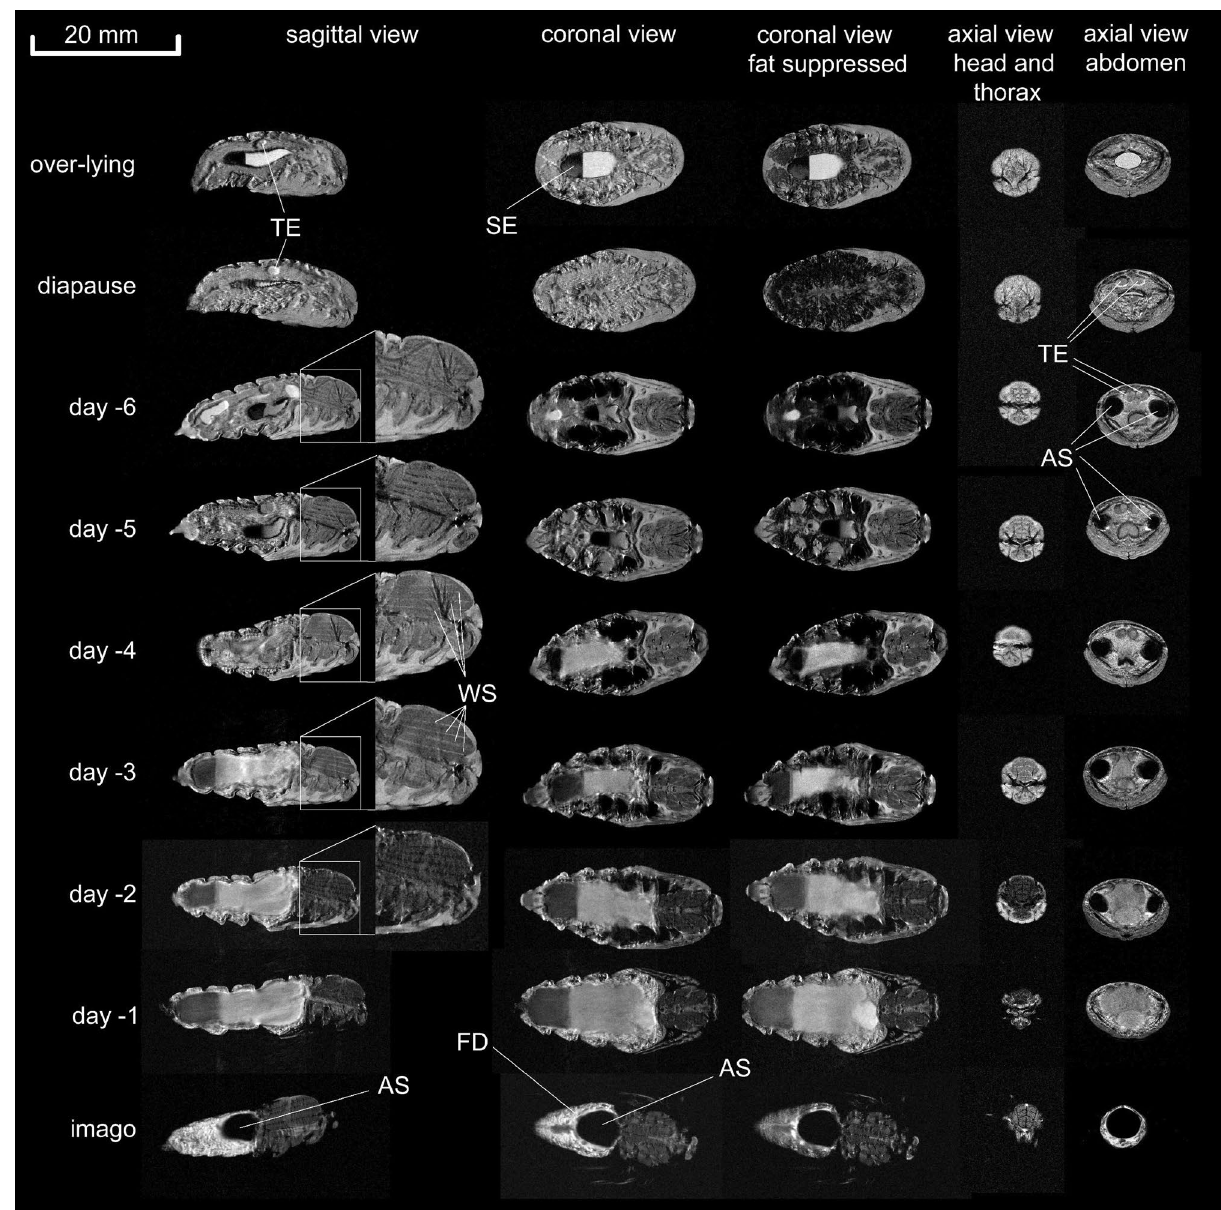
Figure 2. Development of a male pupa from diapause to imago on a day-to-day basis. Sagittal and axial view of the abdomen of male pupae showing the anlages of the testes (TE) in the diapause. Before the moth withdrew the aqueous liquid from the leg and wing sheaths, lines with intense water signal (WS) appeared between the flight muscles. Air sacs (AS) were deflated during diapause and evolved during development (see axial view of the abdomen). Shortly before eclosion, air sacs are marginalised by the inflating gut and rectum filled with meconium consisting of soluble and insoluble metabolites. In male moths, a residual fat deposit (FD) around the gut is evident when comparing non-suppressed and fat-suppressed images. In imagoes, air sacs move to a central position in the abdomen close to the metathorax; SE